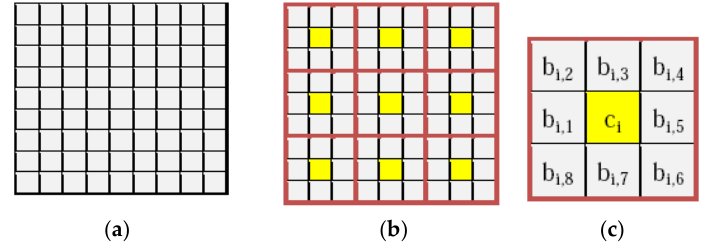
Figure 1. Partitioning the cover image into blocks. Specification of the above figures are: ( a ) cover image I ; ( b ) I , partitioned by 3 × 3 blocks; and ( c ) i th Block.